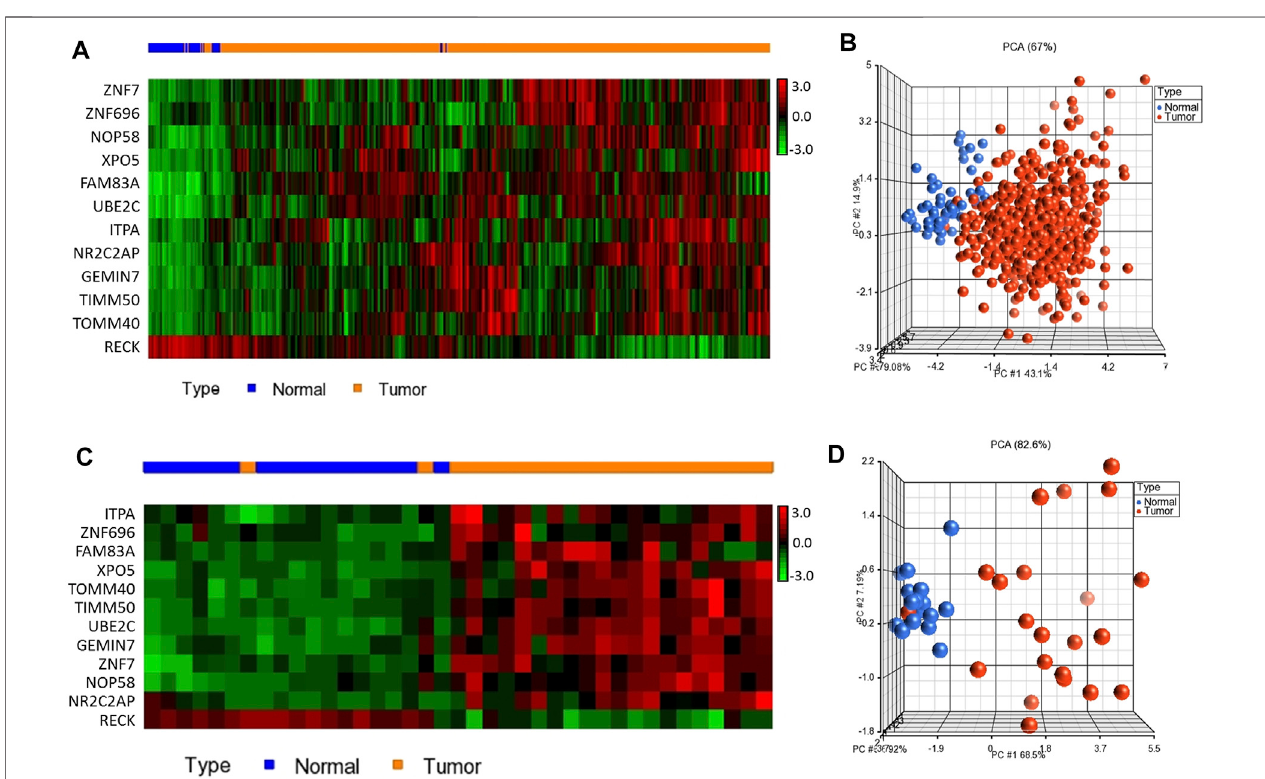
FIGURE 2 | Two-dimensional hierarchical clustering using our gene signature clearly separated patients from normal controls in (A) TCGA ( n = 576) and (C) E-MTAB-5231 ( n =39),respectively. Thehierarchicalclustering revealed twomainclusters,onemainly composed oftumors and another composed ofnormalcontrols. Samples are denoted in columns and genes are denoted in rows. Unsupervised PCA for (B) TCGA ( n = 576) and (D) E-MTAB-5231 ( n = 39). Red indicates tumor and blue denotes normal